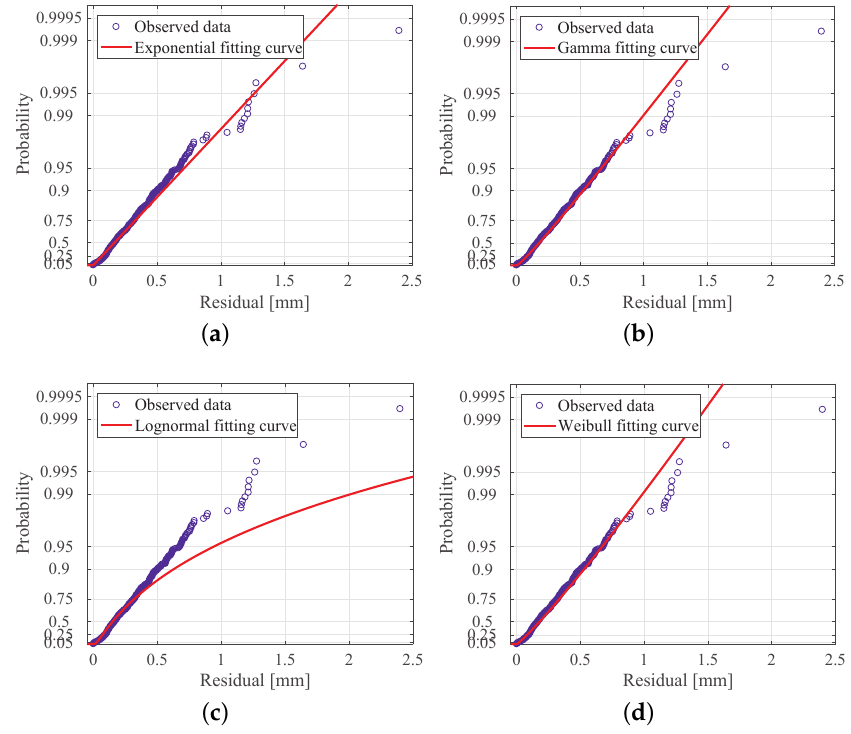
Figure 12. Univariate CDF fitting curves of | ε | 9 − 5 : ( a ) Exponential distribution function, ( b ) Gamma distribution function, ( c ) Lognormal distribution function, ( d ) Weibull distribution